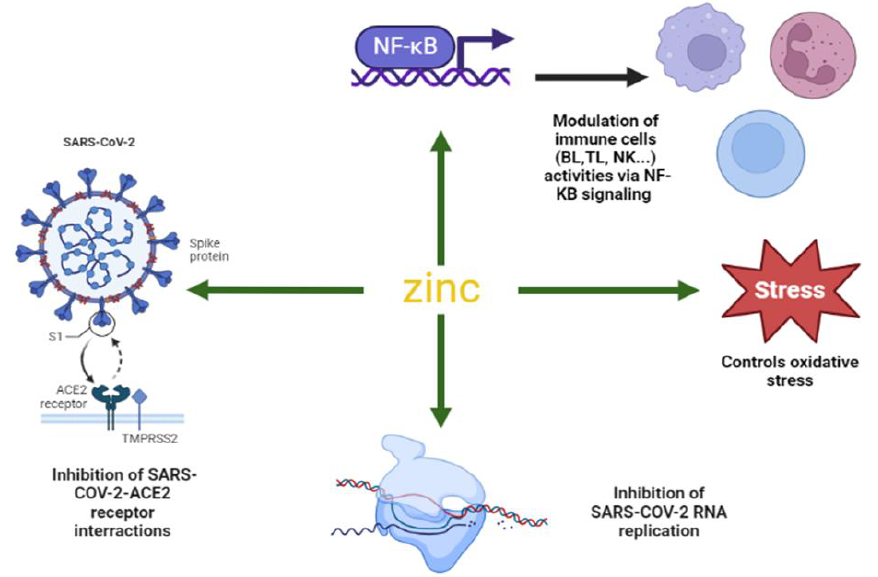
Figure 2. The molecular mechanisms of the anti-viral and immunomodulatory roles of zinc during COVID-19 infection. (ACE2): Angiotensin-converting enzyme 2, (BL): B lymphocytes, (TL): T lym- phocytes, (Nk): Natural killer cells. [35,56,57].